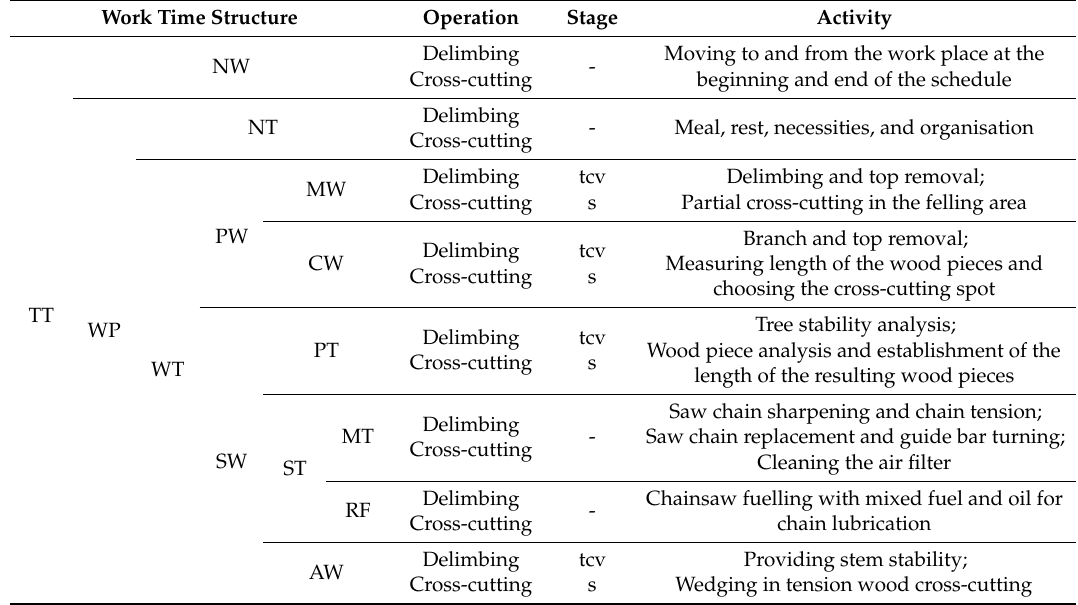
Table 2. Work time structure in delimbing and cross-cutting